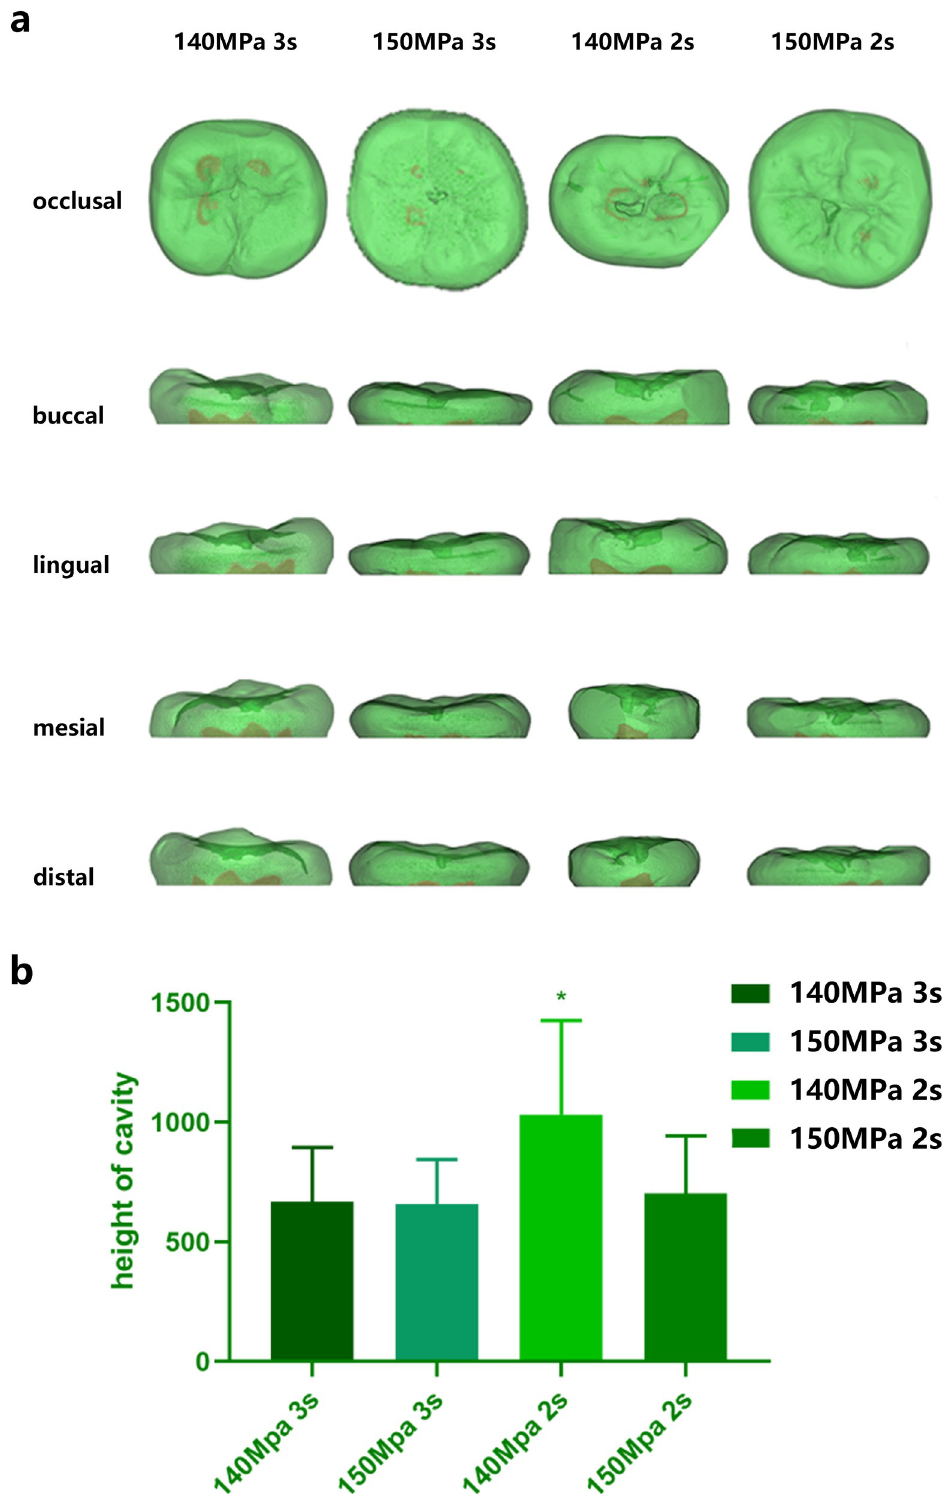
Fig 3. a, The 3D model of cavity drilling by a water jet. The cavities (including the innate pit and fissure) were shown in dark green. The pulp cavities were shown in light red. b, The height of the cavity prepared with a water jet or a high- speed dental drill (n = 10). The asterisk represents statistical significance among the 140 MPa, 2 s water jet group and other groups (p < 0.05). Data represent the mean ( ± SD). https://doi.org/10.1371/journal.pone.0254787.g003 PLOS ONE | https://doi.org/10.1371/journal.pone.0254787 July 23,